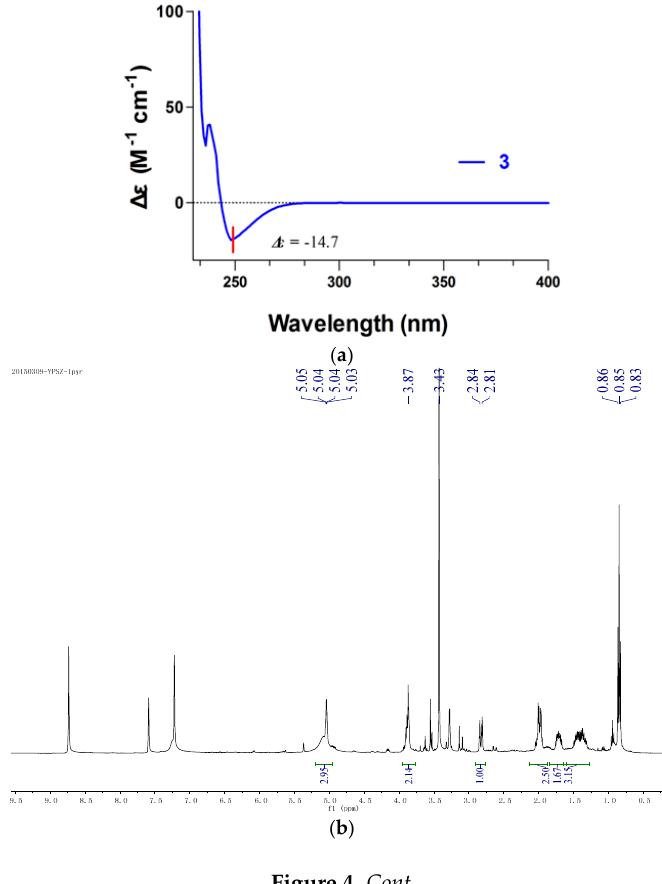
Figure 4. Cont. Figure 4. Cont